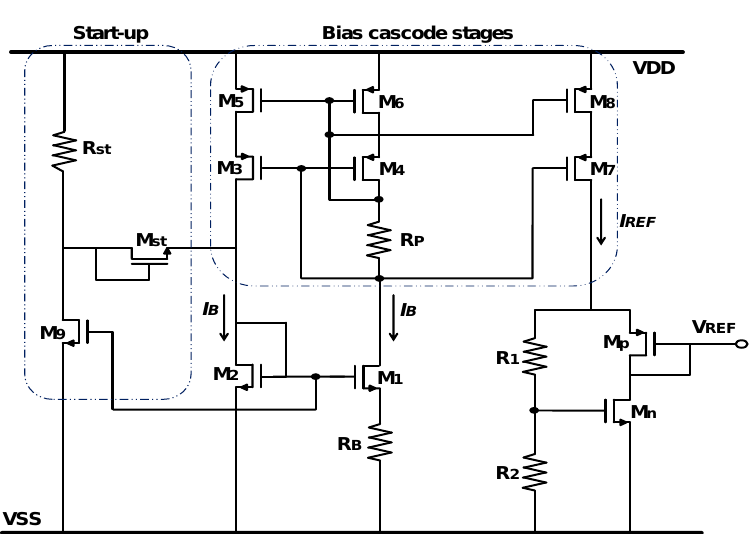
Figure 3. Proposed voltage reference